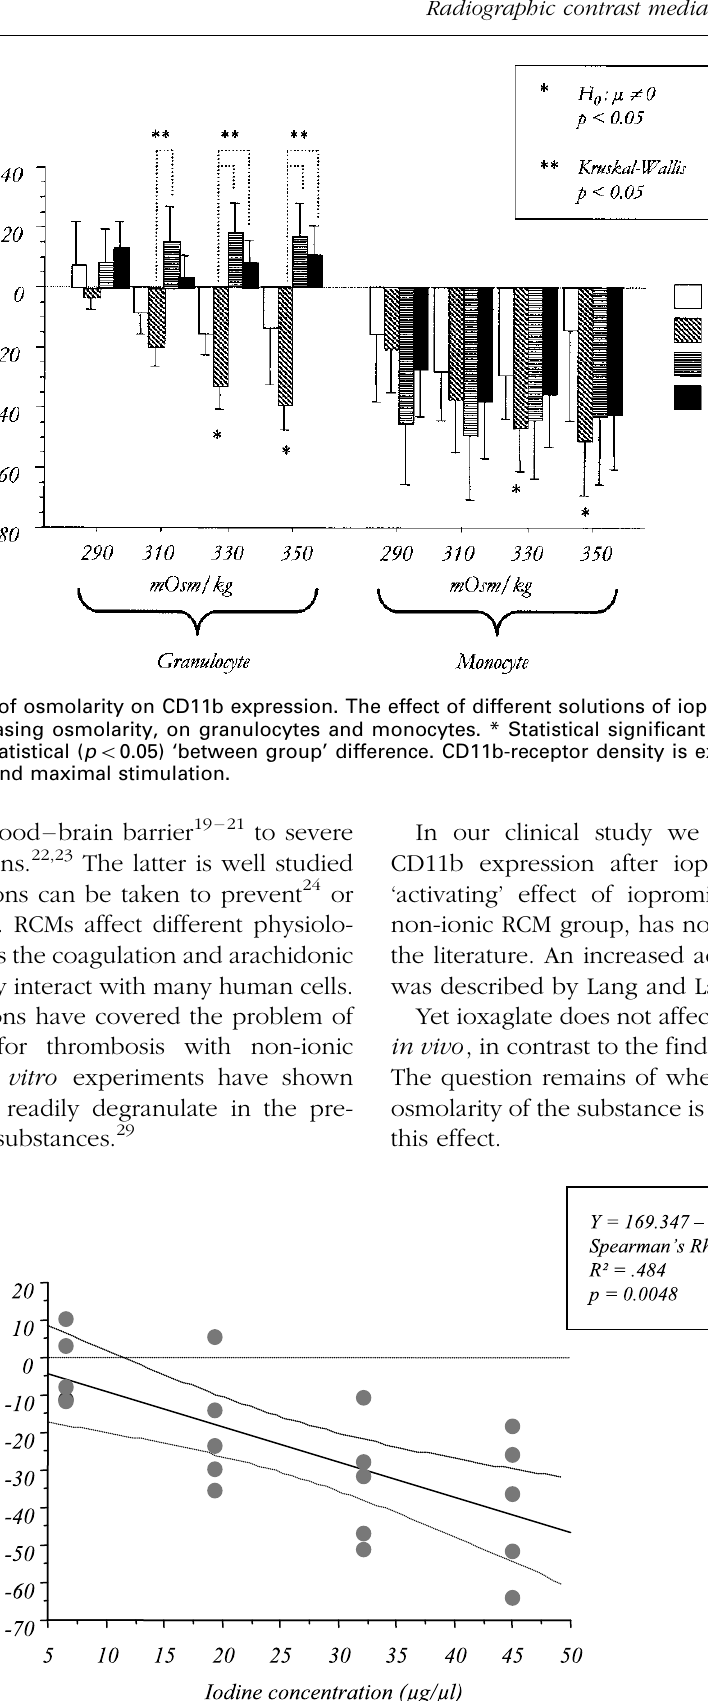
FIG. 4. ‘Invitro’ effect of ioxaglate concentration on CD11b expression. Linear regression analysis for CD11b expression in% MFI (normalized for blank and maximal value) and iodine concentration of ioxaglate ( m g/ m l). Linear regression was corrected by Spearman rank